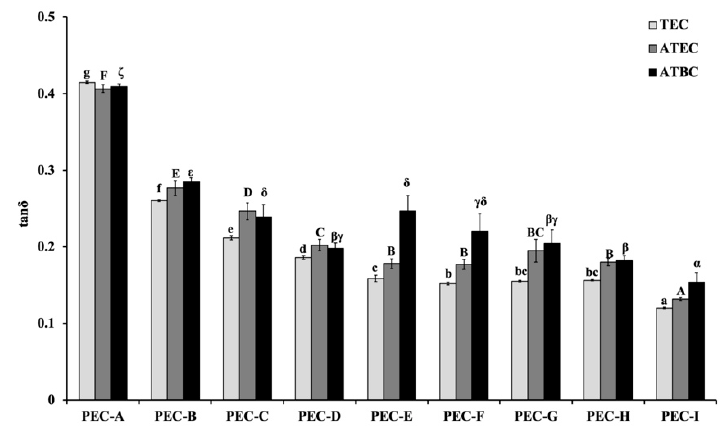
Figure 5. The loss tangent (tan δ ) values at 1 Hz for materials before immersion. Identical letters indicate no significant differences ( p > 0.05).